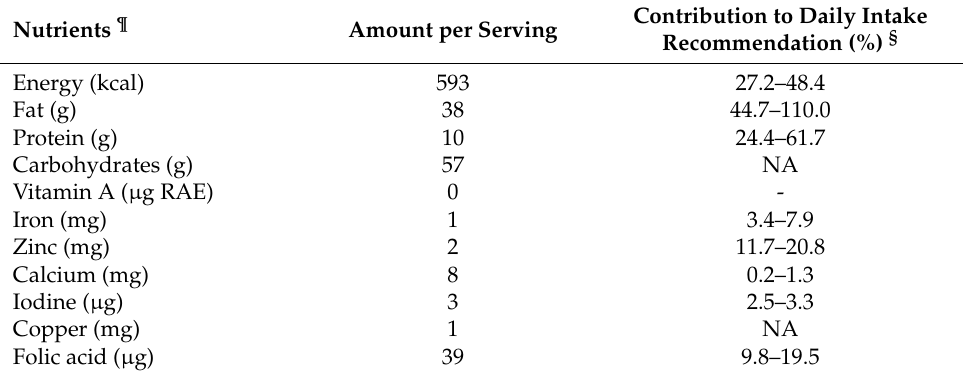
Table 1. Nutrient content of the school